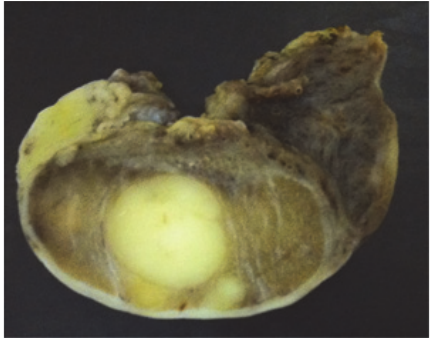
Figure 2: Macroscopy: a solid nodule in the testicular